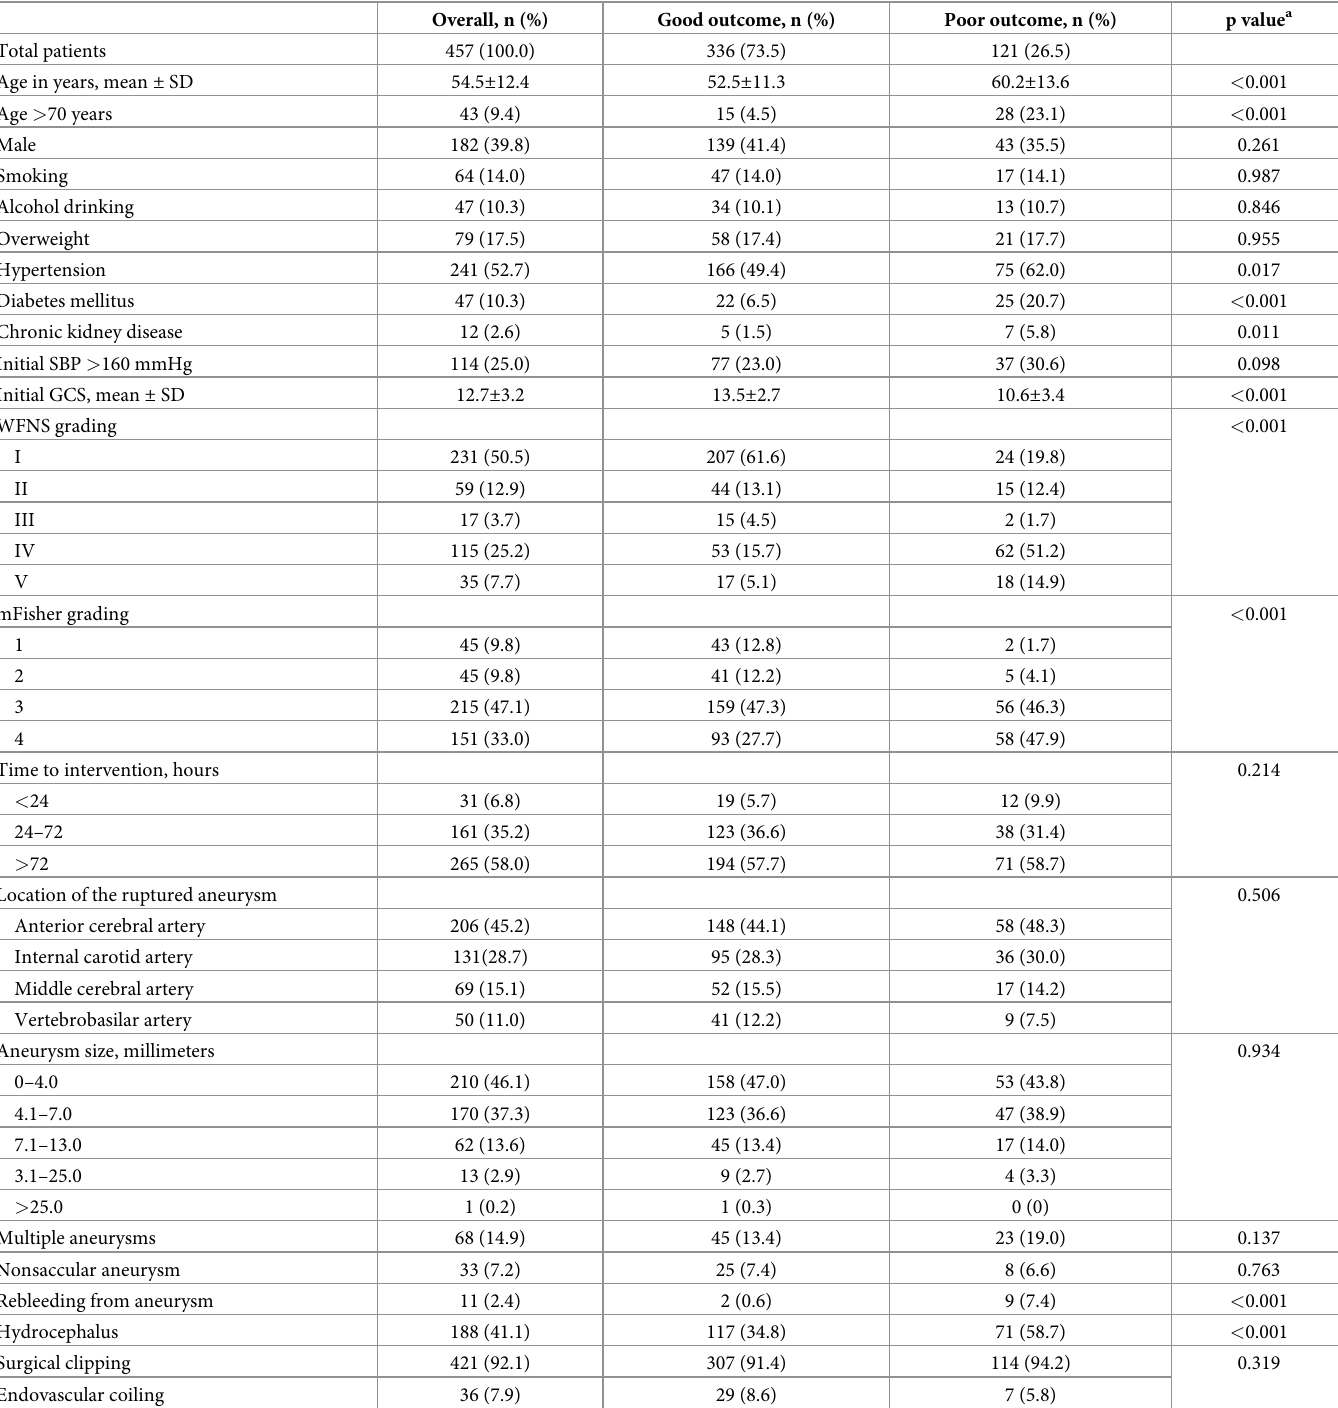
Table 1. Demographic and medical